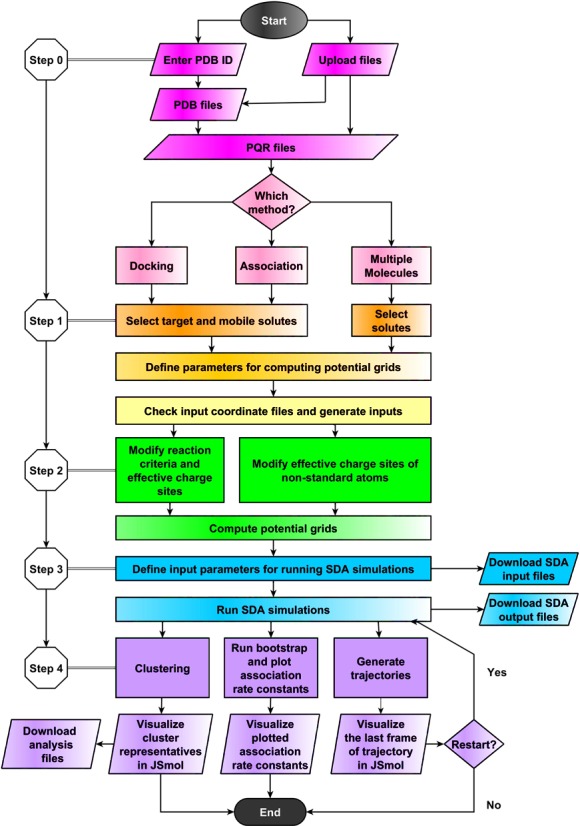
Workflow of webSDA.